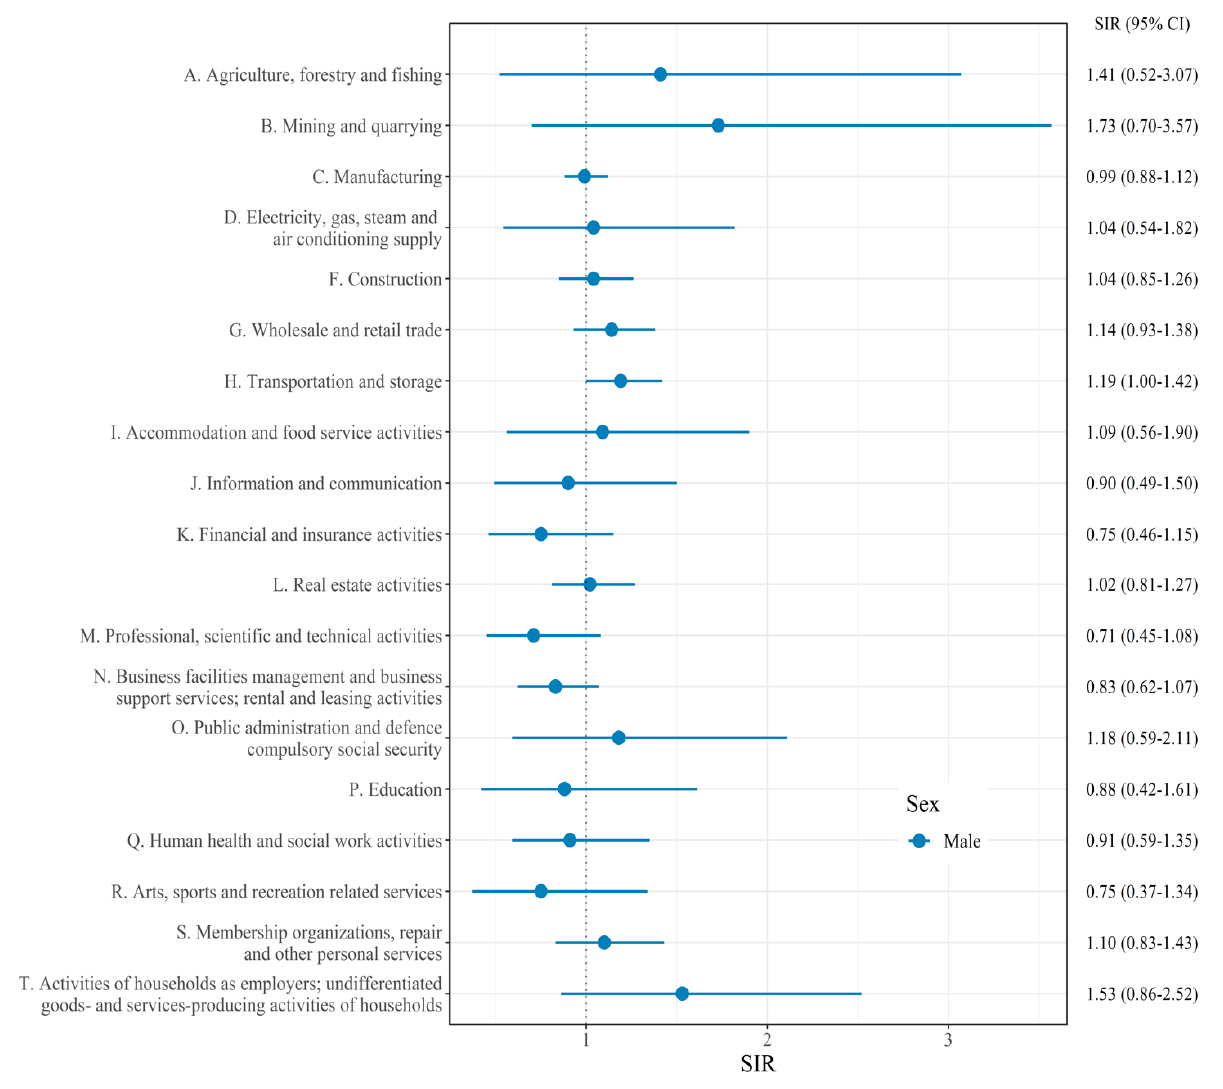
Figure 1. Standardized incidence ratio (SIR) and confidence intervals (CIs) of laryngeal cancer for each industry section.